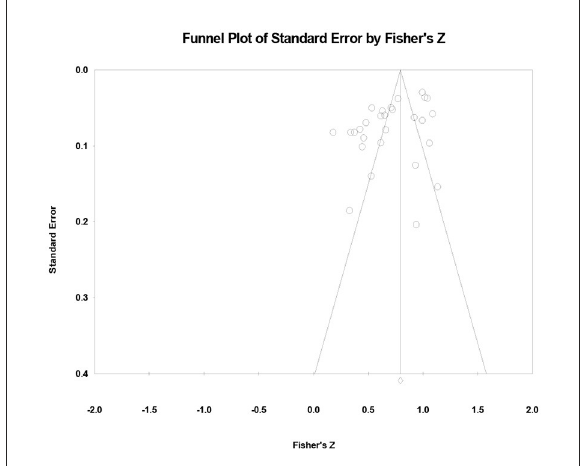
FIGURE2 Funnel plot of effect sizes of the correlation between information technology integration self-efficacy and